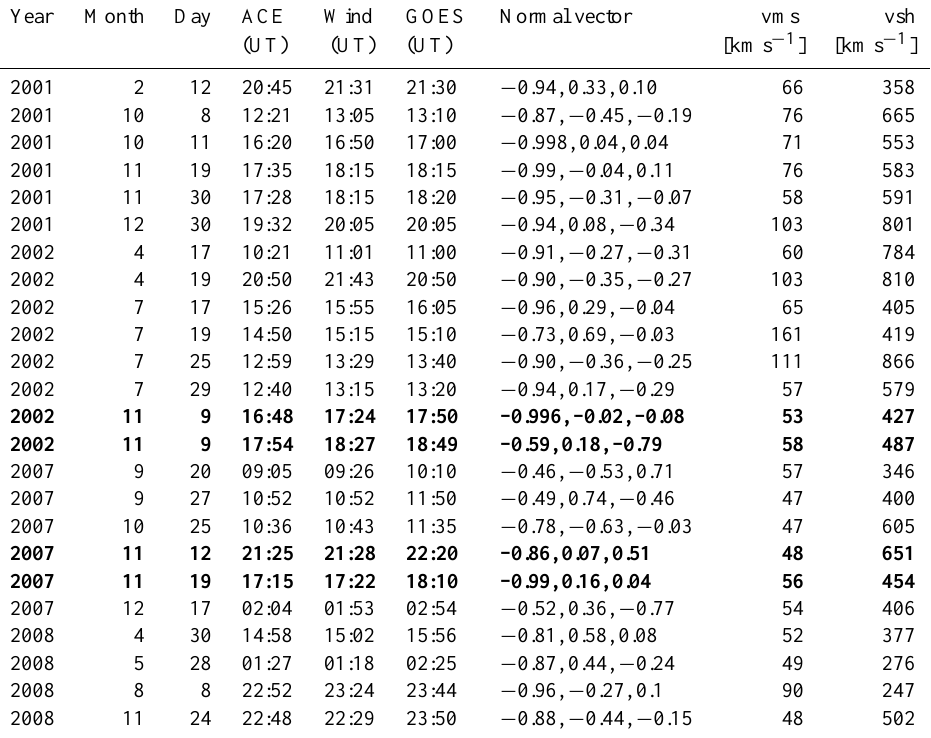
Table 1. Table summarizes 24 events, time in UT observed by the ACE, Wind and GOES spacecraft, and the solar wind IP shock parameters such as IP shock normal estimated from the minimum variance analysis (MVA), and from the magnetic coplanarity (MC) method, magne- tosonic speed in kms − 1 and shock speed in the solar wind frame in kms − 1 . The numbers written in bold are the cases which were shown in the paper in more detail (Sects. 3.1, 3.2, Fig.